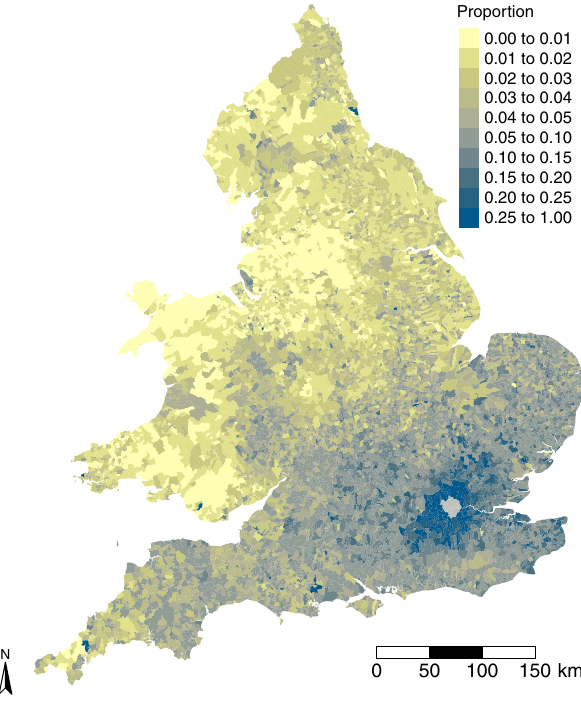
Fig. 5 Lifetime migrants living in London. 1851 lifetime migrants living in London by English/Welsh registration district as a proportion of those born in that place (after Schürer and Day 17 : Fig.